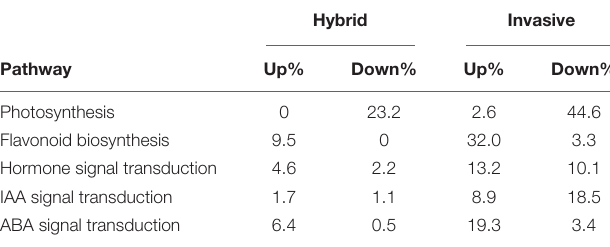
TABLE 4 | Under Cd stress, the up and down regulated percentage of synthesis and signal regulation genes in photosynthesis, secondary metabolites, and hormones in invasive and hybrid